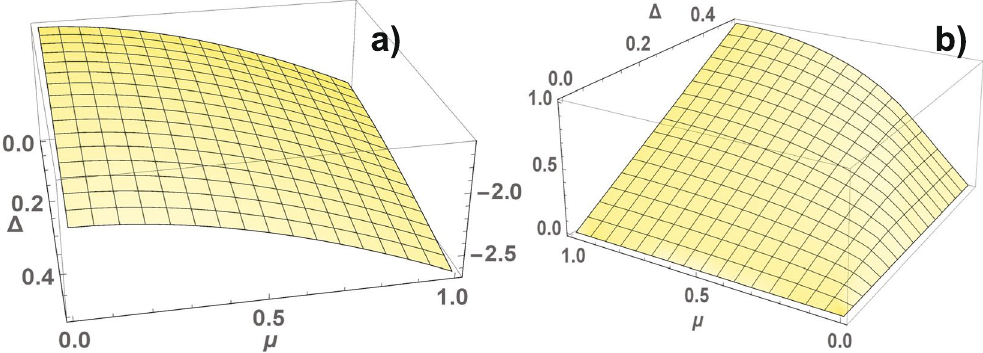
Figure 4. A centered square lattice. The ground state energy per unit cell ( a ) and the gap in the spectrum ( b ) in the TSC state as functions of Δ and μ , the energy minimuma are reached at φ = ± π